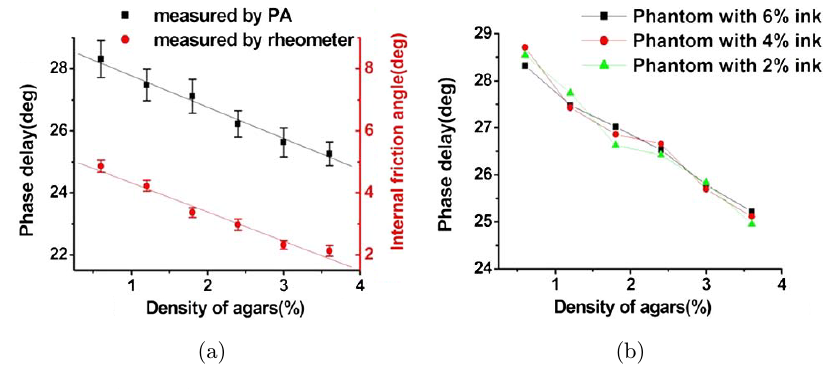
Fig. 2. (a) Comparison between the phase delay of the PA wave and the internal friction angle measured by rheometer. The values of phase delays were averaged over 16 tests. (b) Phase delays obtained by PA measurement from agars with di®erent absorption